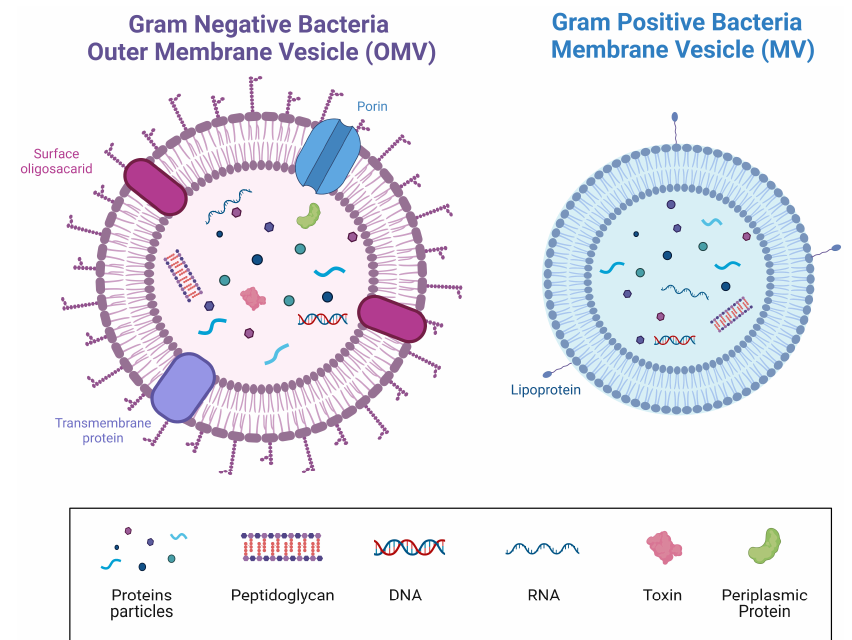
Figure 2. Bacterial extracellular membrane vesicles (EVs). Structure and cargo types comparing Gram-negative and positive bacteria. Created with BioRender.com. Accessed on 1 November 2022.